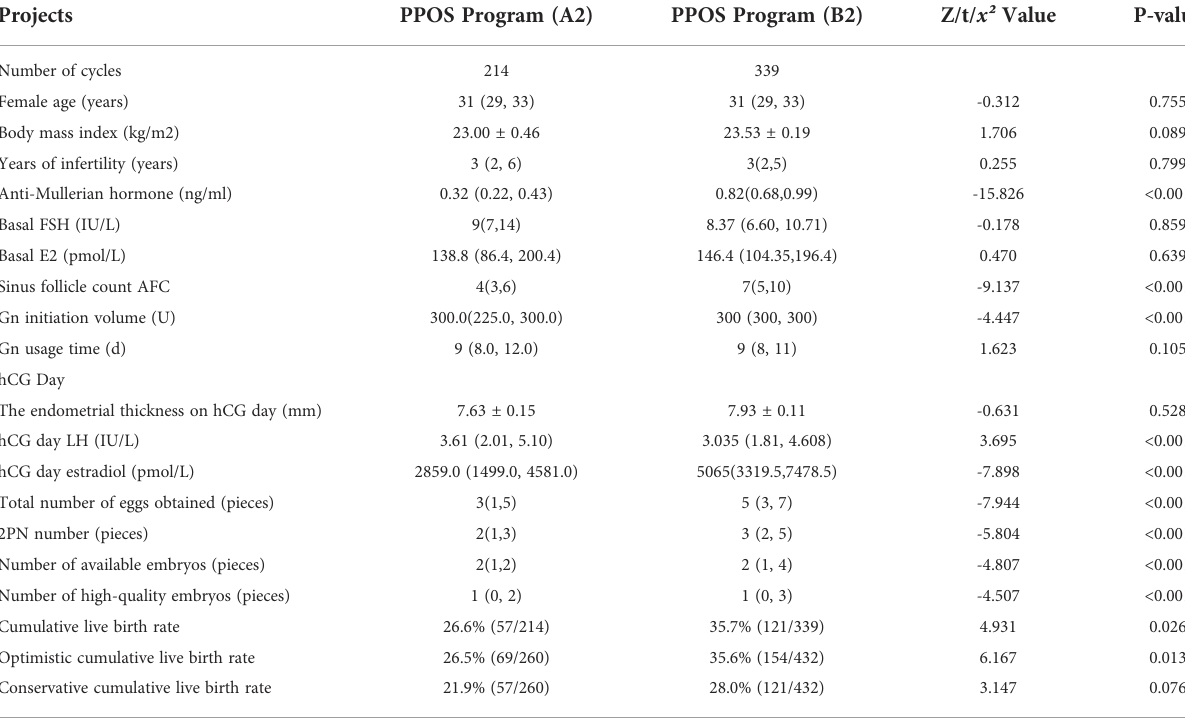
TABLE 2 Comparison of basic clinical information and laboratory results of patients with different AMH levels using PPOS protocol. Projects PPOS Program